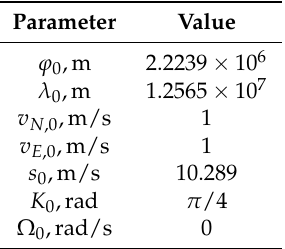
Table 2. Initial